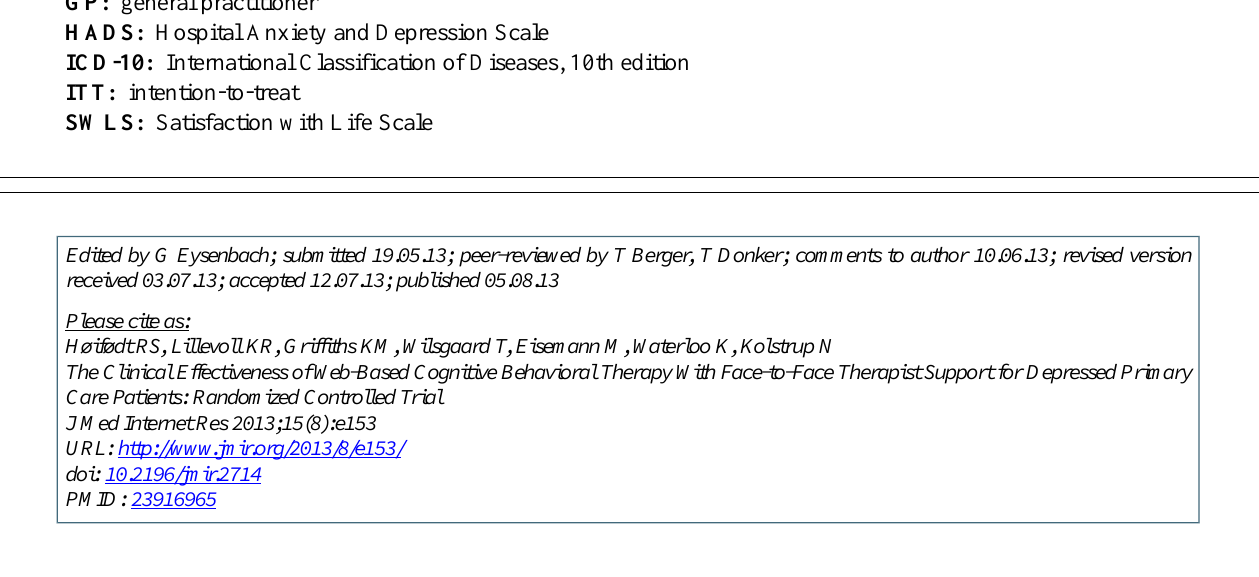
©Ragnhild Sørensen Høifødt, Kjersti R Lillevoll, Kathleen M Griffiths, Tom Wilsgaard, Martin Eisemann, Knut Waterloo, Nils Kolstrup. Originally published in the Journal of Medical Internet Research (http://www.jmir.org), 05.08.2013. This is an open-access article distributed under the terms of the Creative Commons Attribution License (http://creativecommons.org/licenses/by/2.0/), which permits unrestricted use, distribution, and reproduction in any medium, provided the original work, first published in the Journal of Medical Internet Research, is properly cited. The complete bibliographic information, a link to the original publication on http://www.jmir.org/, as well as this copyright and license information must be included.